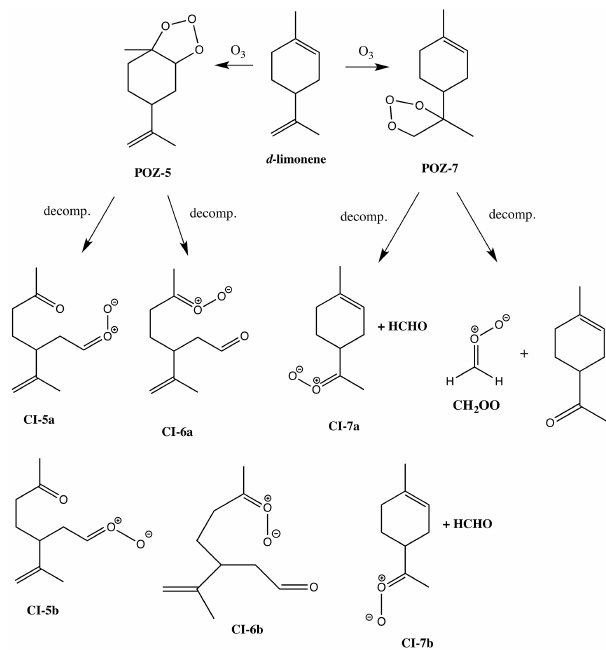
Scheme 4. Mechanism of formation of the four Criegee intermedi- ates (CIs) from limonene